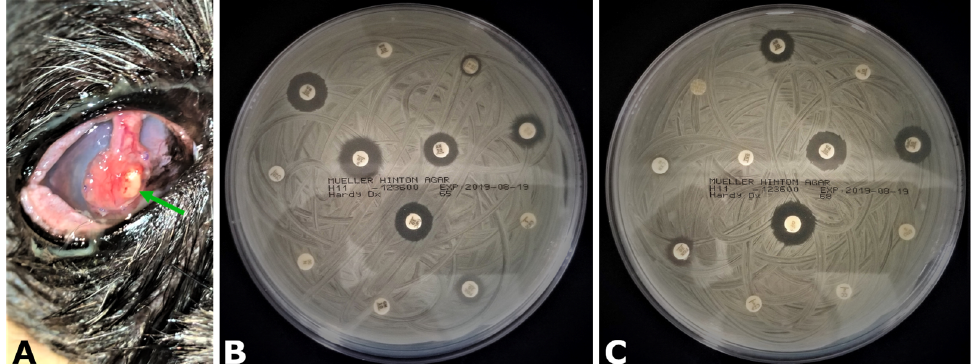
Figure 5. Aggressive corneal infection by Staphylococcus pseudintermedius . ( A ) Patient cornea was severely affected with a focal zone of conjunctival graft destruction at 4 o’clock position in the paracentral graft region (green arrow). Patient was treated with topical ofloxacin and cefazolin and systemic amoxicillin/clavulanic acid immediately after surgery. ( B , C ) Antibiotic susceptibility testing performed for topical ( A ) and systemic antibiotic sets ( B ). The isolate was resistant to the multiple topical (amikacin, cefazolin, cefoxitin, gentamicin, neomycin, ofloxacin, polymyxin B, tetracycline, and tobramycin) and systemic antibiotics (amoxicillin/clavulanic acid, cephalexin, ciprofloxacin, clindamycin, doxycycline, enrofloxacin, marbofloxacin, penicillin G, and sulfamethoxazole/trimethoprim). The isolate was also penicillin-binding protein 2A–positive and susceptible only to topical bacitracin.